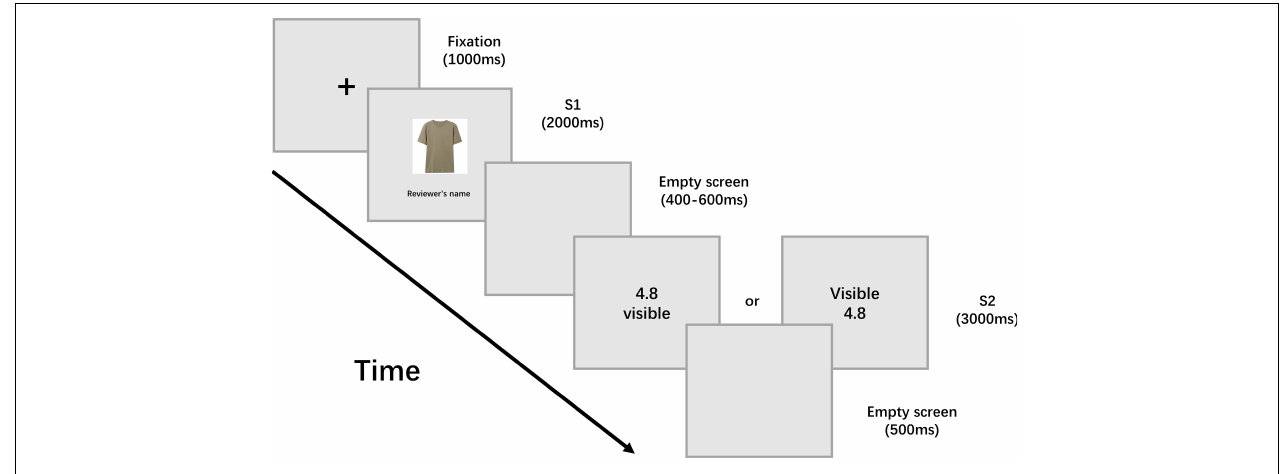
FIGURE 1 | Experimental procedure. Participants were asked to make a purchase decision after viewing the cue information (S2).